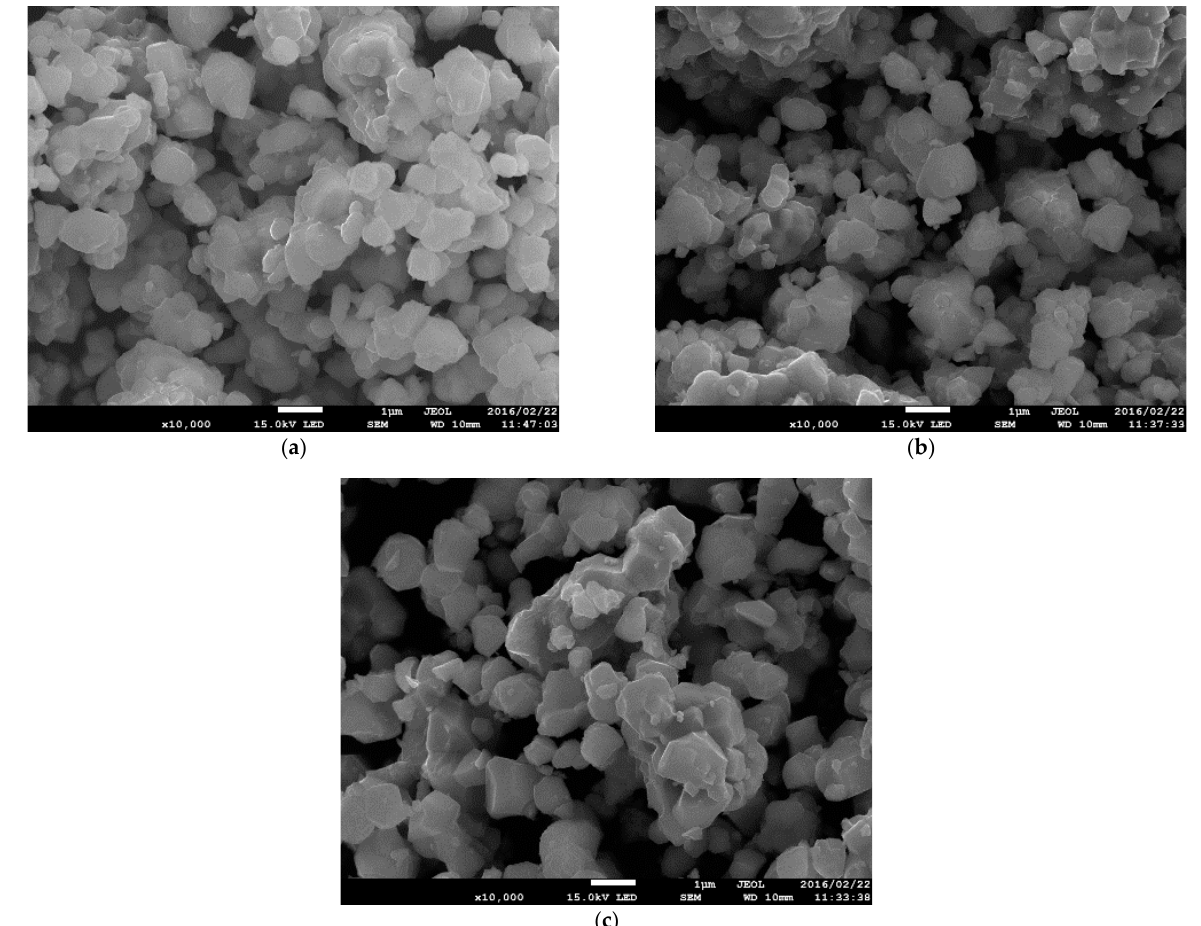
Figure 3. SEM micrographs of reduced ( a ) Sr 2 Fe 1 . 4 Ti 0 . 1 Mo 0 . 5 O 6 −δ ; ( b ) Sr 2 Fe 1 . 4 Ti 0 . 2 Mo 0 . 4 O 6 −δ and ( c ) Sr 2 Fe 1 . 4 Ti 0 . 3 Mo 0 . 3 O 6 −δ powder.